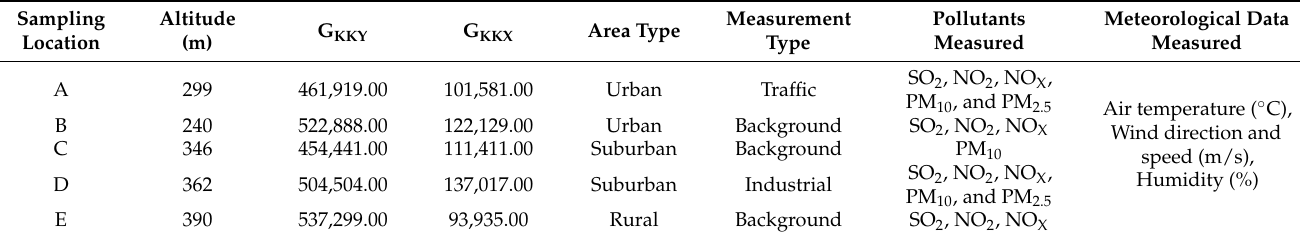
Table 1. Altitude and coordinates of the air quality monitoring